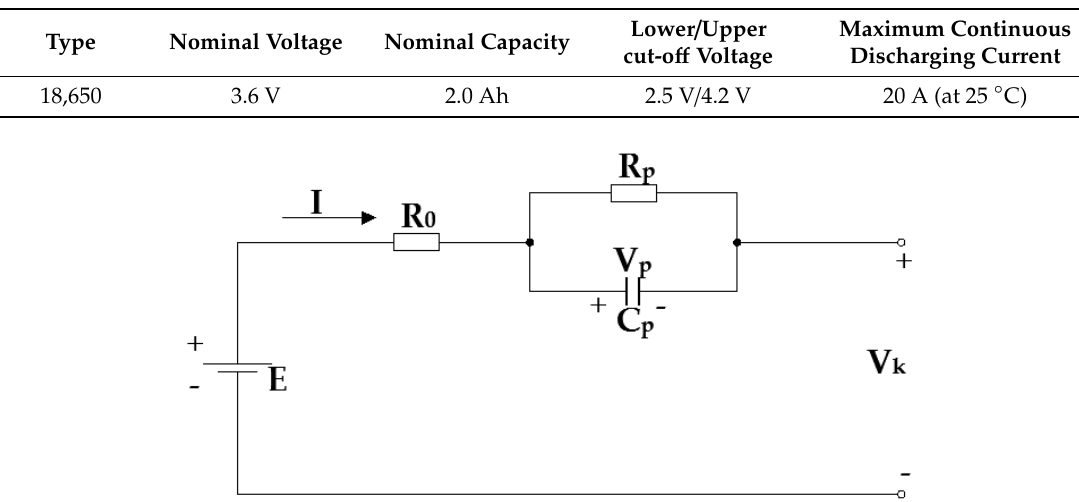
Table 1. Basic specifications of the battery.